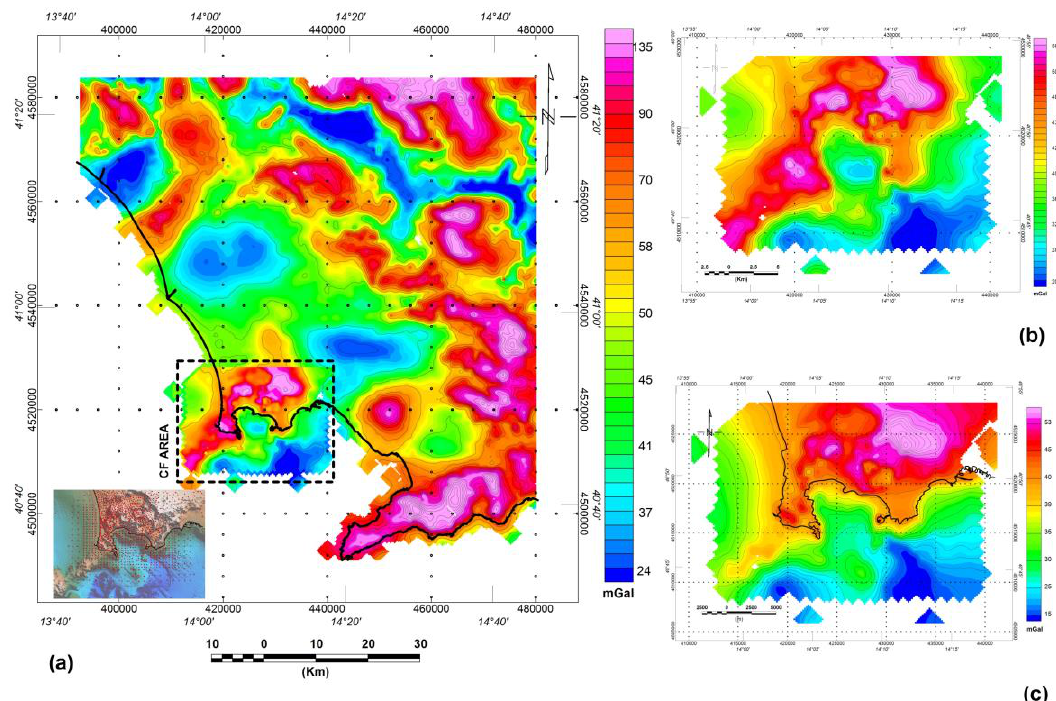
Figure 4. CP Eni Free Air anomaly maps and the onshore and offshore CFc gravity stations distribution in the inset ( a ). CFc Eni Free Air anomaly map ( b ). Phlegraean Fields TGE as derived by VPmg forward modelling. See text for explanation ( c ).